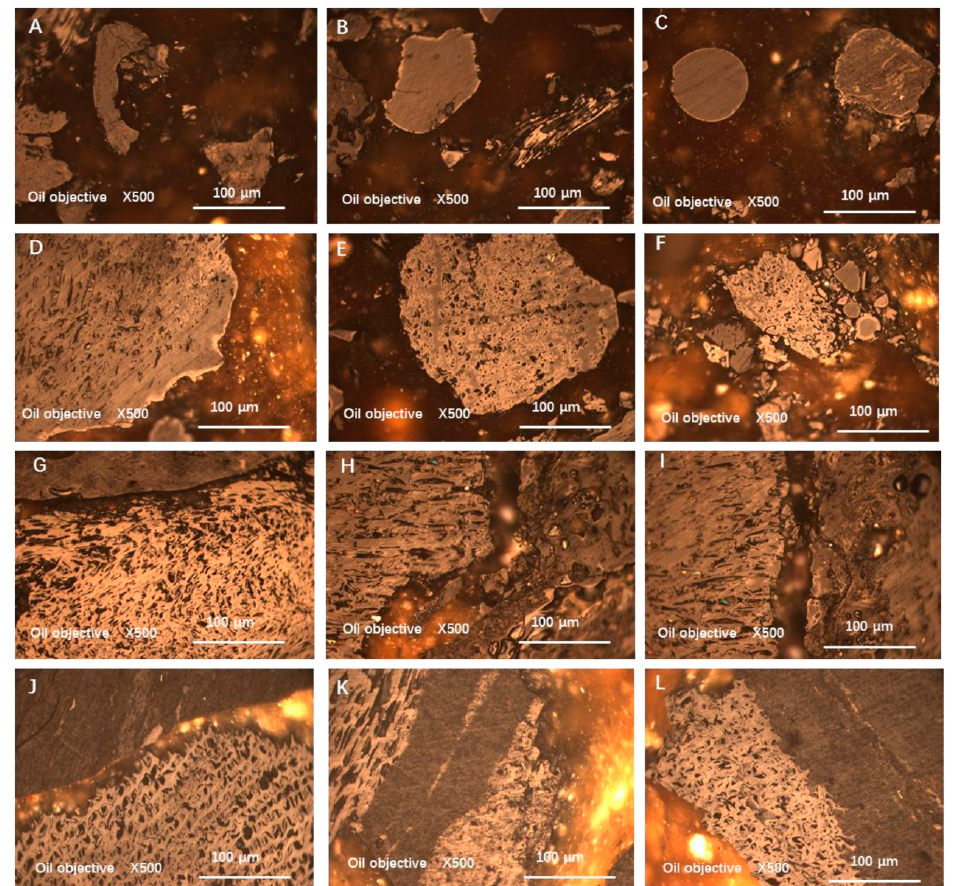
Figure 8. Characteristic images of the maceral liberation from coal by liquid nitrogen quenching. ( A – C ) Liberation characteristics of products from coal with a particle size less than 0.1 mm; ( D – F ) liberation characteristics of products from coal with a particle size between 0.1 and 0.5 mm; ( G – I ) liberation characteristics of products from coal with a particle size between 0.5 and 0.9 mm; and ( J – L ) liberation characteristics of products from coal with a particle size greater than 0.9 mm.